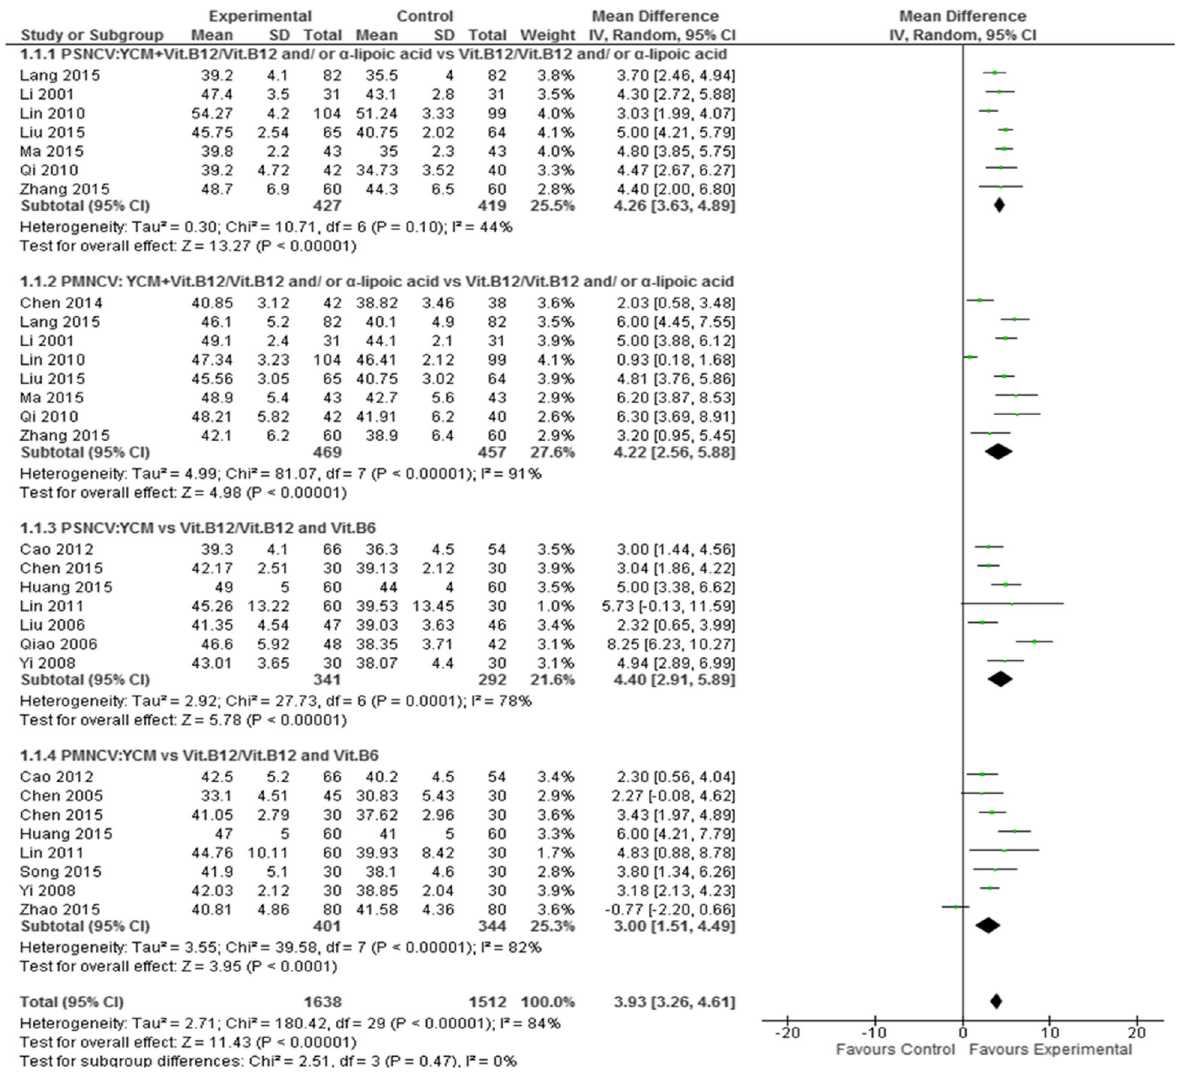
Fig. 3 Forest plot of tibial nerve conduction velocity of YCM on diabetic peripheral neuropathy. Note: TSNCV: tibial sensory nerve conduction velocity; TMNCV: tibial motor nerve conduction